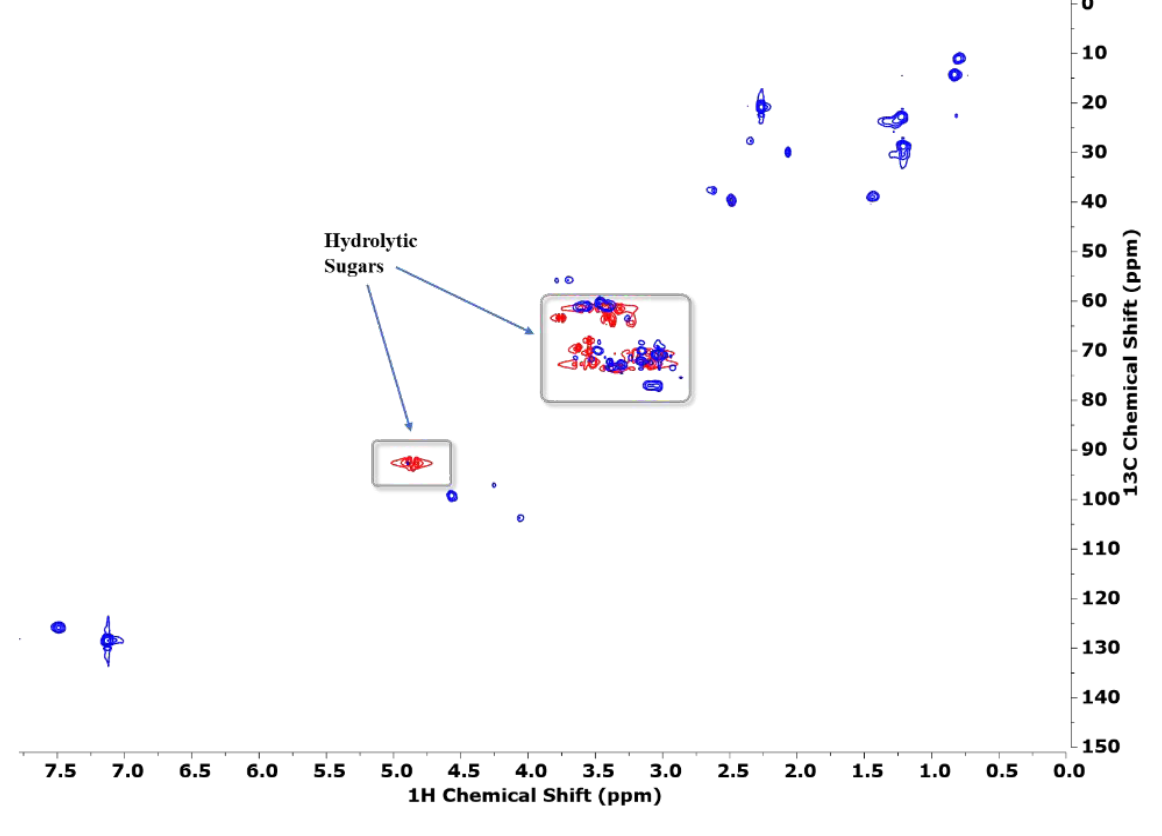
Figure 4. Superimposed HSQC spectra of hydrolytic sugars (blue) and the mixture standards (red). The presence of sugar derivatives, identified by HPLC, became evident by superimpos- ing both spectra. The amount of sugar derivatives in the aqueous extract was considerably higher than that of the other identified compounds. This is in accordance with what was expected since most hydrolytic sugars are water-soluble, while the compounds from lignin decomposition tend to be hydrophobic. In addition, some phenolic and aliphatic derivatives were also observed. Signals in the HSQC spectra in the region 120–130 ppm/7.0–7.5 ppm, which is typical of aromatic moieties, are also found. These signals can be assigned to C–H aromatic bonds resulting from the presence of structures from lignin depolymerisation, e.g., guaiacyl moieties [33]. Those structures may appear as products of the reaction of carbohy- drates with phenolic moieties, affording glycosides. Figure 5a resumes the presumed routes of the formation of several glycosides. The reaction of those structures with carbohydrates may occur between a phenolic hydroxy group or a hydroxy group on the alkyl chain, with the anomeric carbon of the carbohydrate to form an acetal. Ethers are also formed by the reaction of the lignin derivatives with non-anomeric carbohydrate positions. Moreover, C -glycosides can be formed by a reaction of the anomeric carbon with a phenolic hydroxy in an acidic medium through a Fries-type reaction or rearrangement, which involves the formation of an O -glycoside, which undergoes intramolecular rearrangement to afford a C -glycosylated compound [34]. This type of structure has more of an affinity to the aqueous phase due to the hydrophilic profile of the sugar moiety